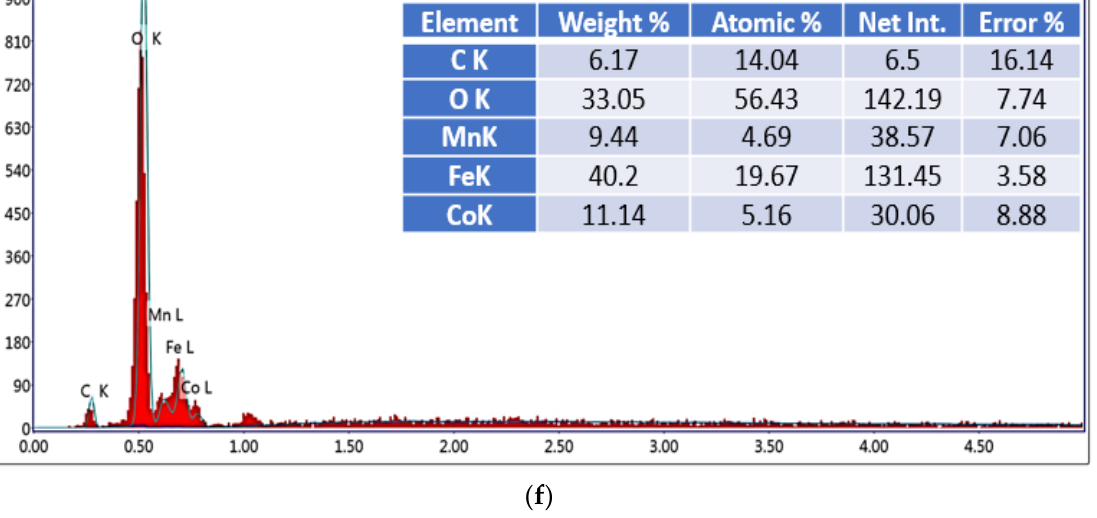
Figure 3. ( a-f ) . EDX pattern of the Co − Mn ferrite/graphene composites.